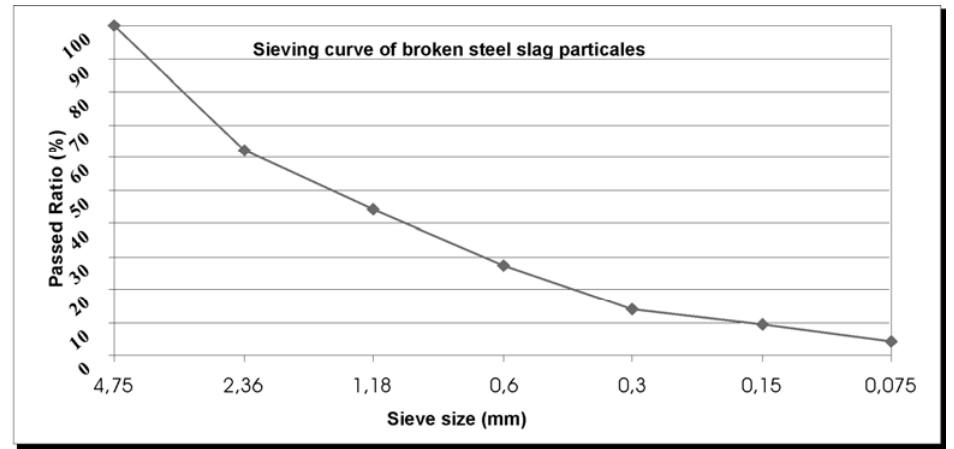
Fig 1. Sieving curve of broken steel slag